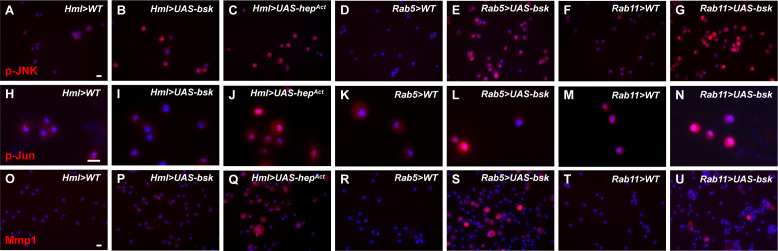
Analysis of the p-JNK, p-Jun, and Mmp1 levels in circulating hemocytes.(A–U) Circulating hemocytes were stained with antibodies against p-JNK (A–G), p-Jun (H–N), and Mmp1 (O–U). Hml>UAS-hepAct, Rab5>UAS-bsk, and Rab11>UAS-bsk hemocytes showed elevated levels of p-JNK, p-Jun, and Mmp1, whereas only the p-JNK levels and not the p-Jun and Mmp1 levels were increased in Hml>UAS-bsk hemocytes. Scale bar: 10 μm.